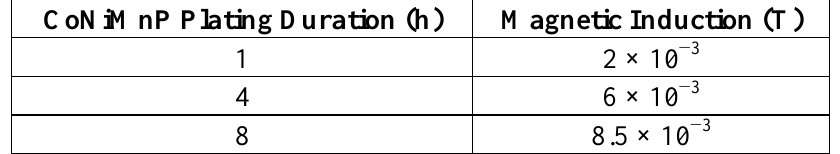
Table 2. The magnetic induction generated by electroplated CoNiMnP plated for 1, 4, and 8